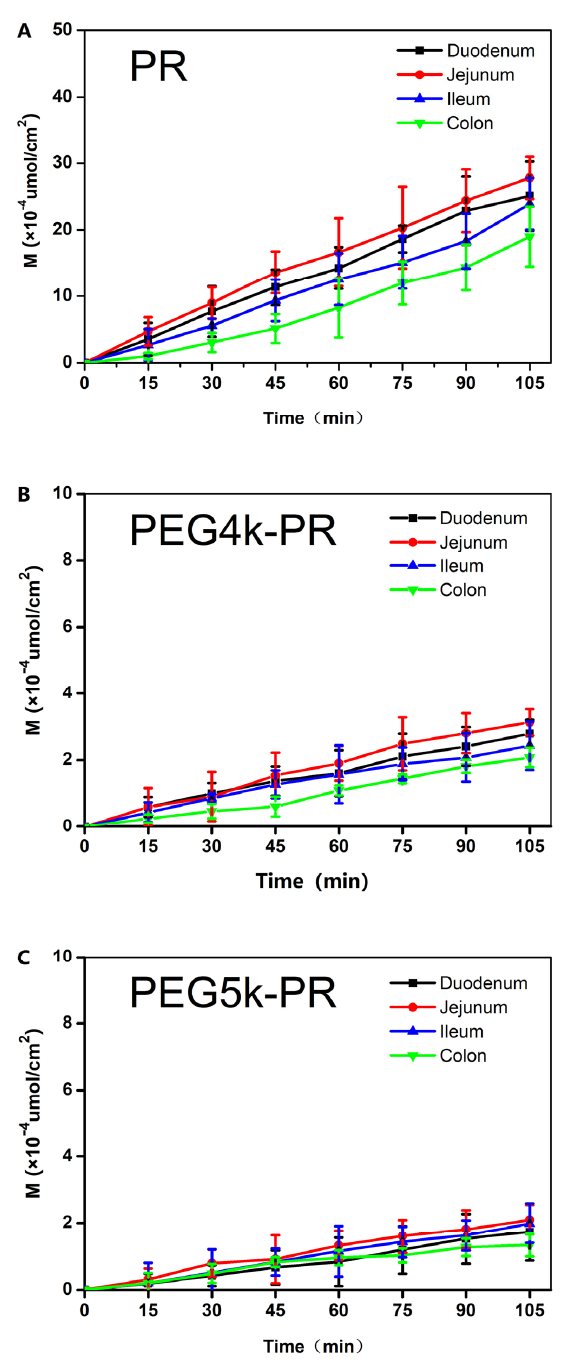
Figure 7. Cumulative intestinal permeable amount versus time of PR ( A ), PEG4k-PR ( B ), and PEG5k-PR ( C ) at 56 μ M in different intestinal segments. Data are shown as mean ± SD, n = 3. PR and PEG, which have been widely used for intestinal absorption studies in humans, are poorly absorbed by the intestines due to different mechanisms: PR has a low affinity to the gastric intestinal (GI) mucosa, while the size and shape of the high molecular weight PEG limit its intestinal